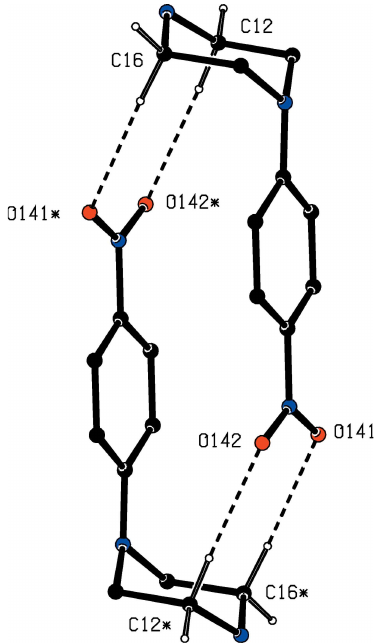
Figure 7 Part of the crystal structure of compound (II) showing the linkage of an inversion-related pair of cations by two independent C—H (cid:2)(cid:2)(cid:2) O hydrogen bonds, drawn as dashed lines. For the sake of clarity, the anions, the H atoms bonded to those C atoms that are not involved in the motif shown, and the unit-cell outline have been omitted. The atoms marked with an asterisk (*) are at the symmetry position (1 (cid:5) x , 1 (cid:5) y , 2 (cid:5) z ).